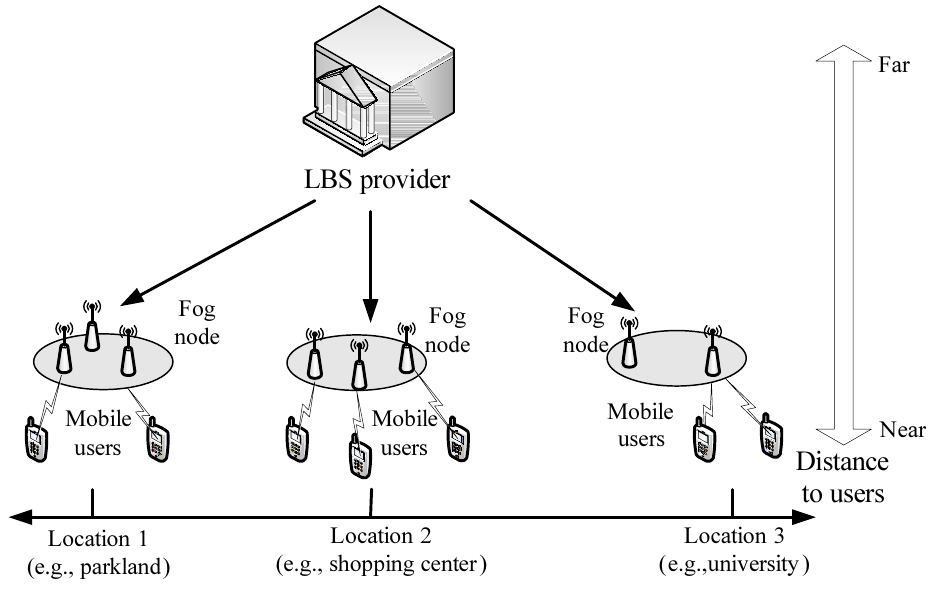
Figure 1. System model under